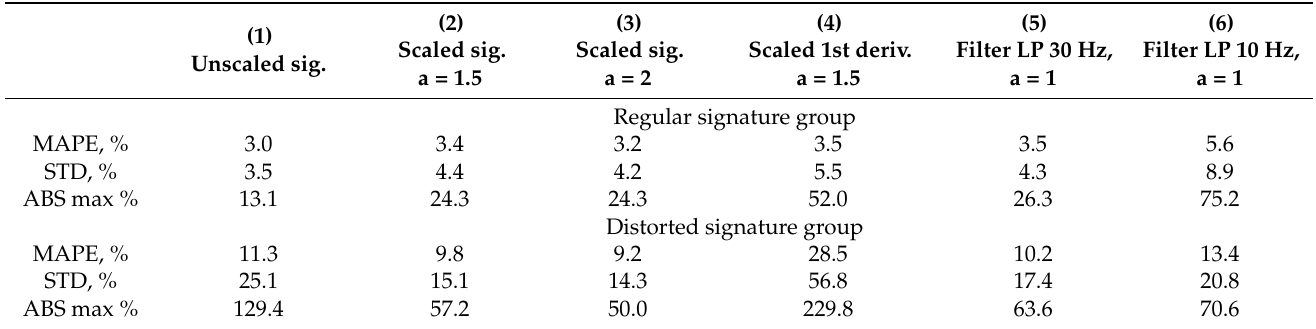
Table 2. Comparison of the performance of rescaled speed estimation algorithms.